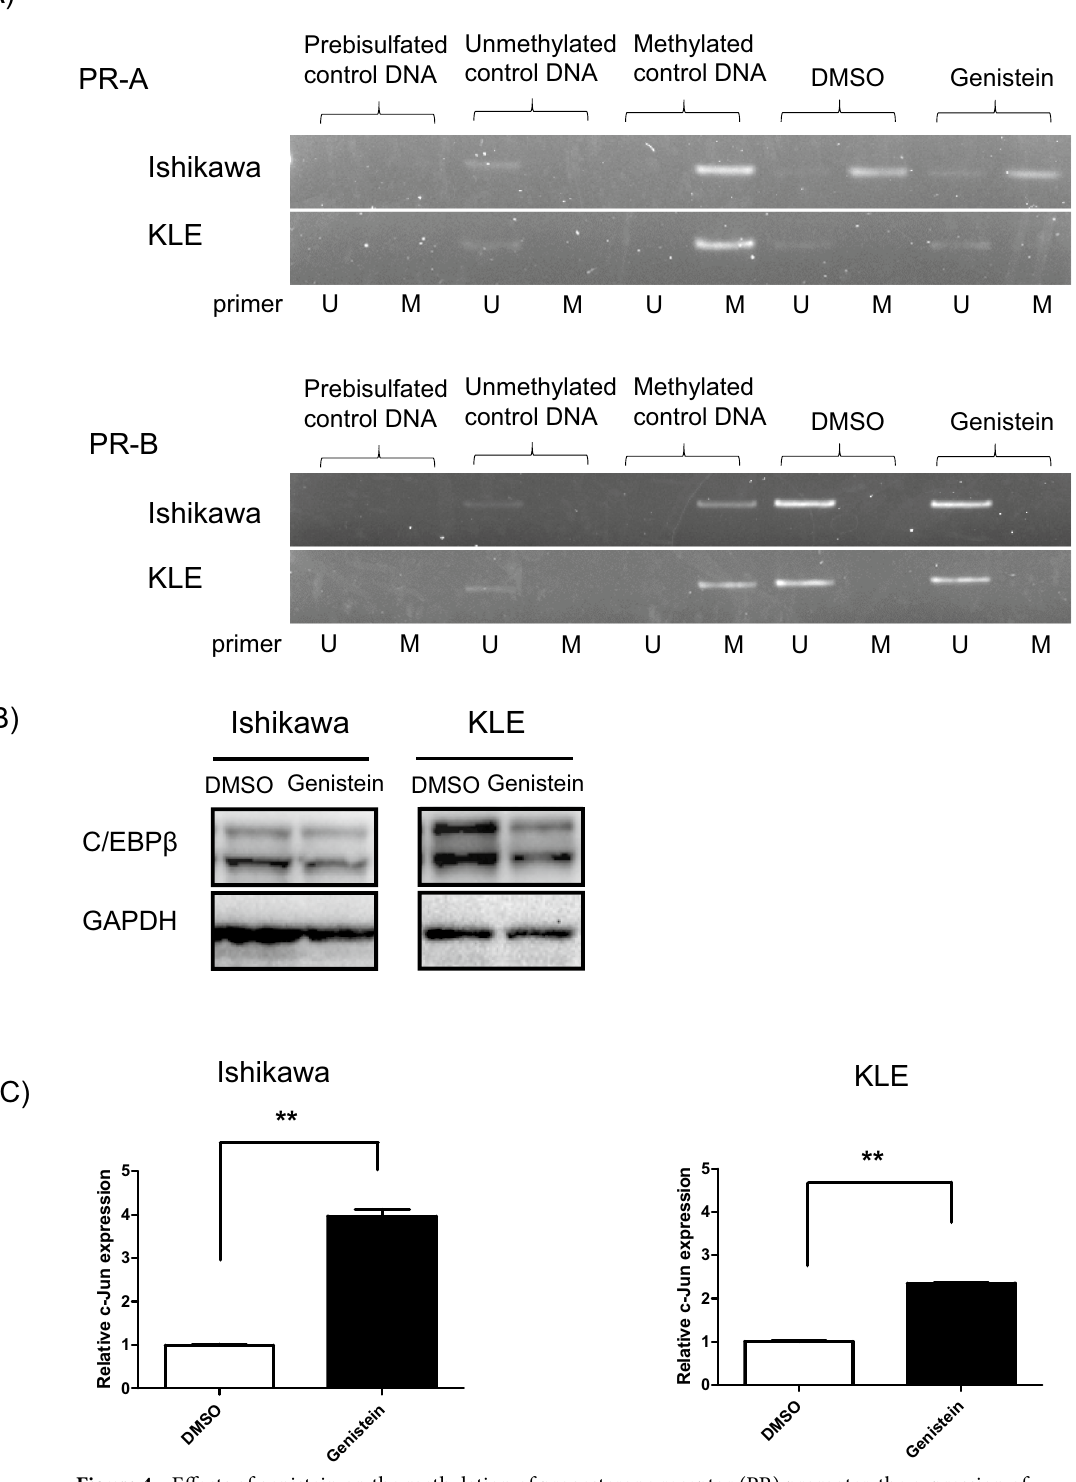
Figure 4. Effects of genistein on the methylation of progesterone receptor (PR) promoter, the expression of CCAAT/enhancer binding protein beta (C/EBPβ), and the activation of c-Jun N-terminal kinase (JNK) pathway. The methylation status of promoters of PR-A and PR-B was assessed in Ishikawa and KLE cells treated with genistein for 144 h using methylation-specific polymerase chain reaction (MSP) ( A ). The expression of C/EBPβ in cancer cells was evaluated by western blot analysis ( B ). The expression of c-Jun in cancer cells was examined by quantitative polymerase chain reaction (qPCR) ( C ). Western blot analysis of proteins related to the JNK pathway in cancer cells after 24 h of exposure to 0, 10, 20, 40, 80, and 160 μM genistein ( D ) and at 0, 1, 3, and 6 h after treatment with 100 μM genistein ( E ). Full-length western blots are presented in Supplementary Fig. 5–6. Data represent the mean ± standard error of the mean (n = 3). P values are based on Student’s t -test. ** P <